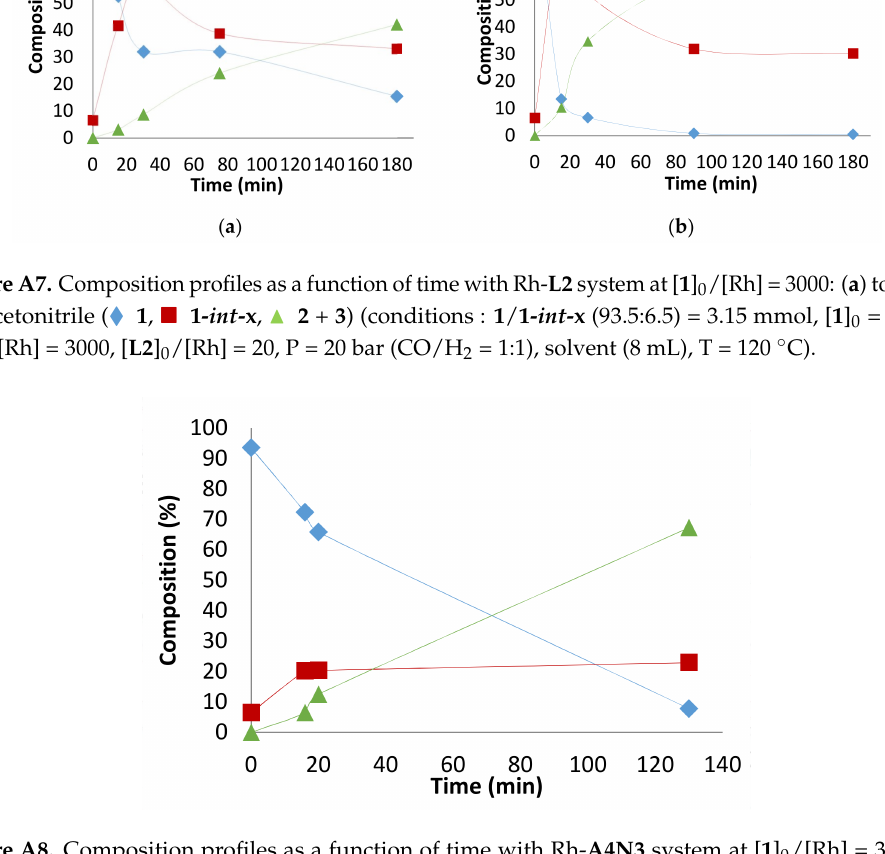
Figure A8. Composition profiles as a function of time with Rh- A4N3 system at [ 1 ] 0 /[Rh] = 3000 in toluene ( (cid:7) 1 , (cid:4) 1- int -x , (cid:78) 2 + 3 ) (conditions: 1 / 1- int -x (93.5:6.5) = 3.15 mmol, [ 1 ] 0 = 0.4 M, [ 1 ] 0 /[Rh] = 3000, [ligand] 0 /[Rh] = 20, P = 20 bar (CO/H 2 = 1:1), solvent (8 mL), T = 120 ◦